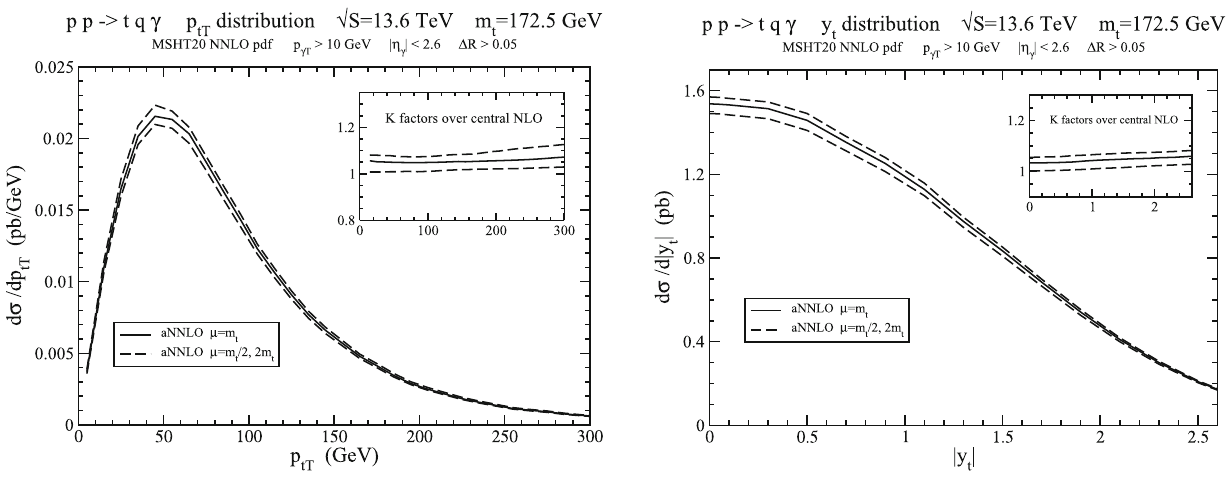
Fig. 8 The aNNLO top-quark p T (left) and rapidity (right) distributions in tq γ production at 13.6 TeV LHC